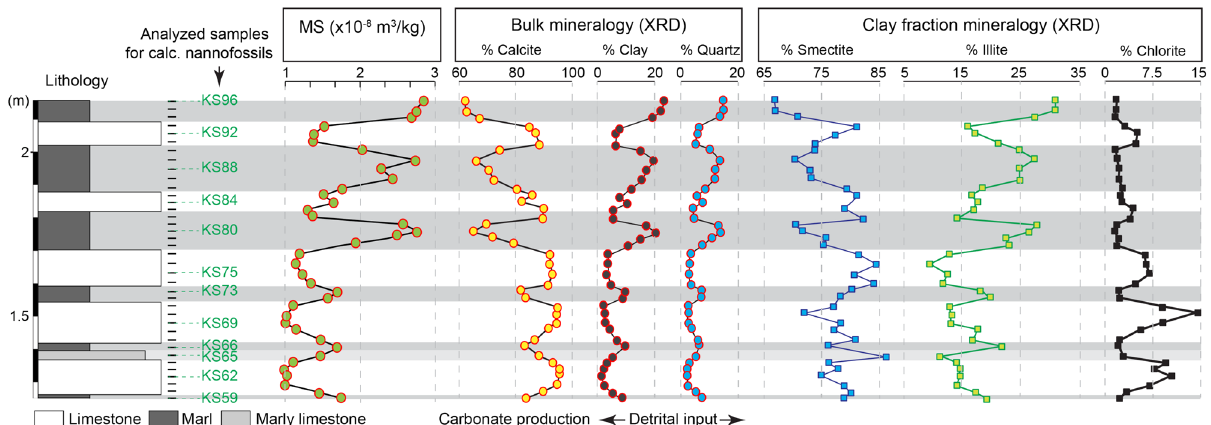
Figure 5. Integrated magnetic susceptibility (MS), bulk and clay fraction mineralogy in five successive marl- limestone couplets at La Cluse section showing similar cyclic variations between MS, detrital component (quartz and clay) and detrital illite in marly interbeds, reflecting enhanced continental runoff conditions. Numbers in green depict the samples used for calcareous nannofossil